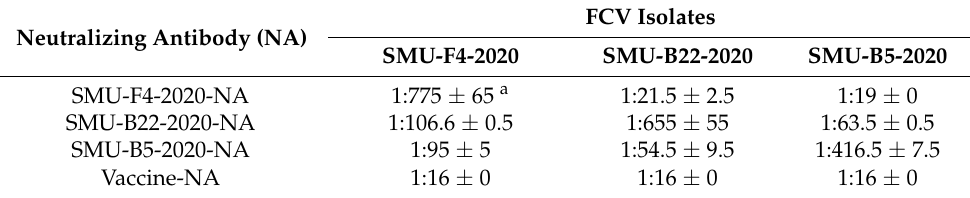
Table 2. Determination of serum neutralizing antibody titers to FCV isolates in mice. Neutralizing Antibody